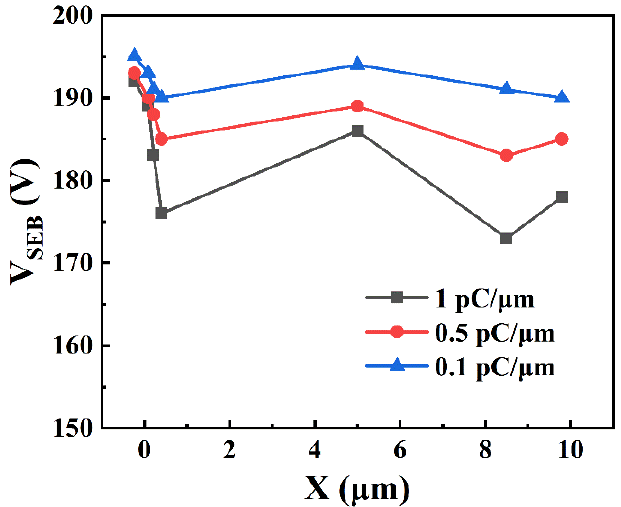
Figure 7. The V SEB for heavy ions with different LETs vertically striking at different positions along the SJT SOI LDMOS device structure.